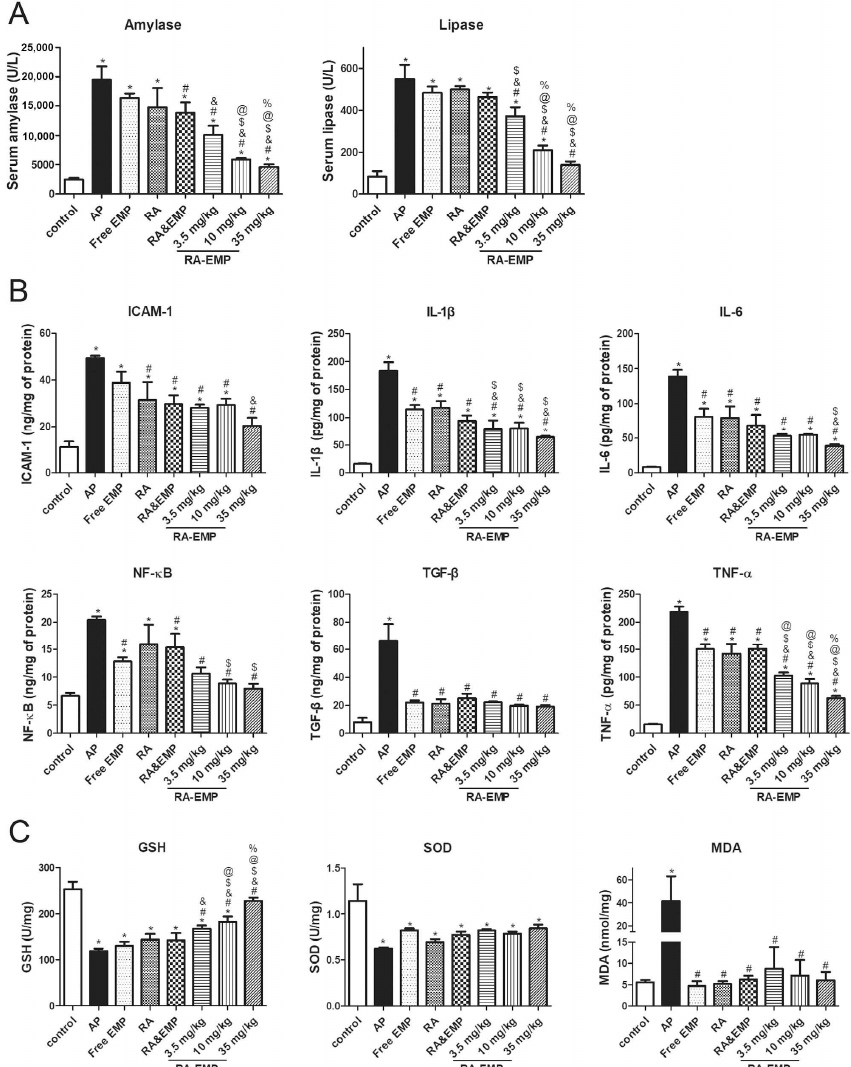
Figure 3. Biochemical assay, proinflammatory cytokines assay, and tissue oxidative stress analysis. ( A ) Amylase and lipase levels in serum after treatment with different concentrations of micelles (in order: physical mixture group; 3.5 mg/kg group; 10 mg/kg group; 35 mg/kg group). ( B ) Levels of pro-inflammatory cytokines in pancreatic tissues of experimental groups treated with different concentrations of micelles (in order: physical mixture group; 3.5 mg/kg group; 10 mg/kg group; 35 mg/kg group). ( C ) GSH, SOD, and MDA contents in the pancreas. * p < 0.05 vs. healthy control group; # p < 0.05 vs. AP control group; & p < 0.05 vs. free EMP group; $ p < 0.05 vs. RA group; @ p < 0.05 vs. RA&EMP group; % p < 0.05 vs. RA-EMP 3.5 mg/kg group. Reprinted from [83]. Copyright 2022, with permission from